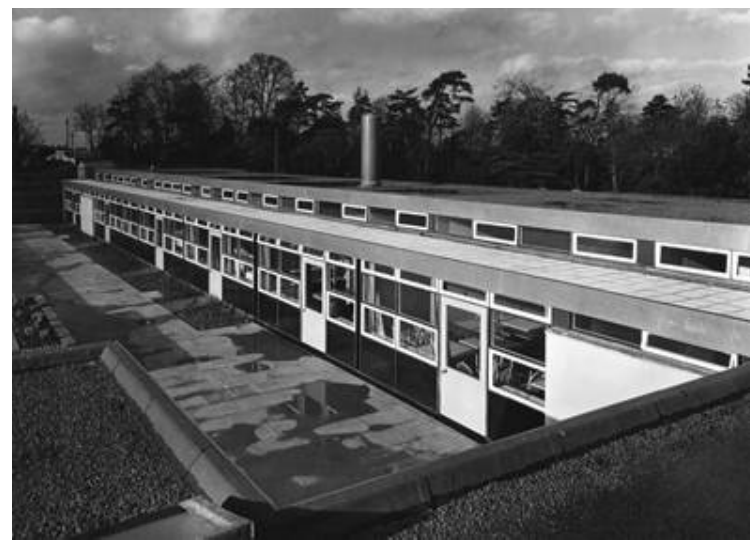
Figure 5. Admission and Treatment Unit, Fair Mile Hospital, Wallingford, Oxfordshire, the south side of the female ward wing, 1956 (Source: Architectural Press Archive/RIBA Collections, RIBA Ref No: RIBA56473)